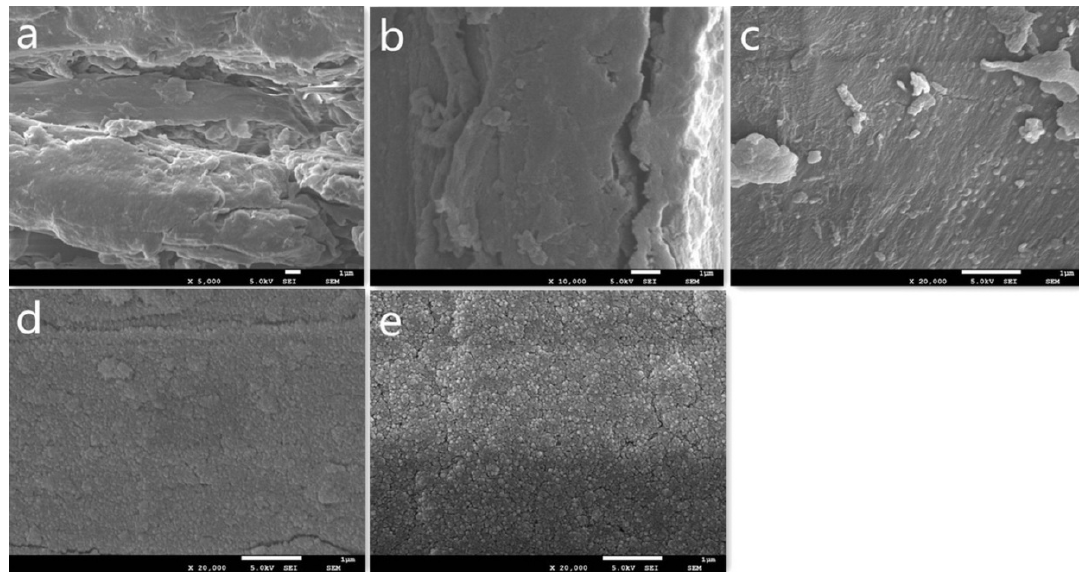
Figure 7. SEM image of nano-Al metallized wood (( a ) the original wood, ( b ) sputtering Al 20 s, ( c ) sputtering Al 50 s, ( d ) sputtering Al 15 min, ( e ) sputtering Al 60 min).